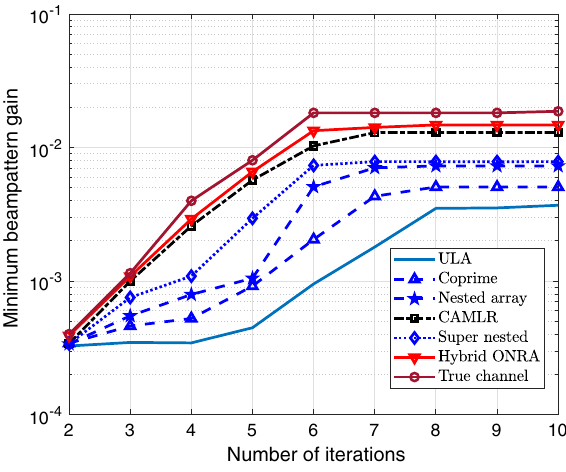
Fig. 9 The optimized beam pattern gain versus the number of